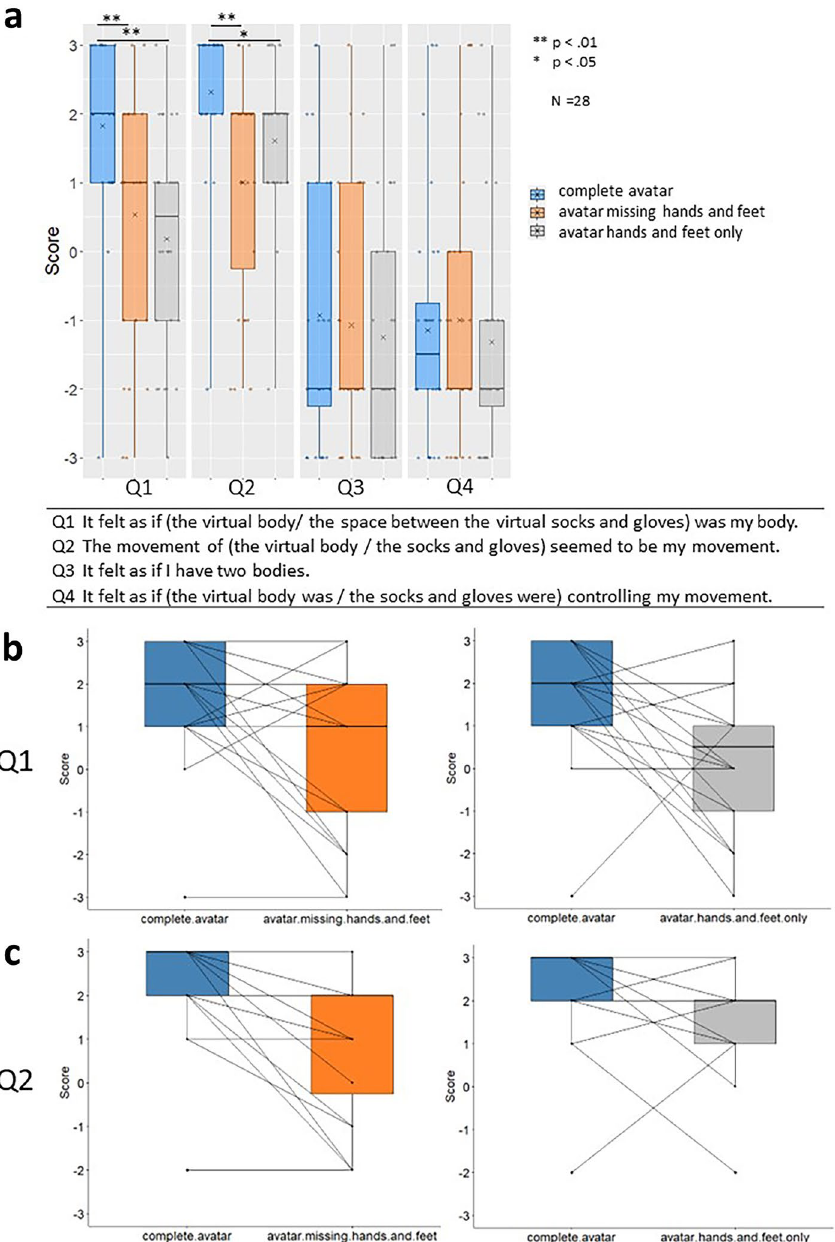
Figure 1. ( a ) All results of the questionnaire. The horizontal thick lines indicate the medians and “x” indicate the mean values. Individual data points are plotted in dots. ( b ) Plots of pairwise comparison lines between individual data points in Q1. ( c ) Plots of pairwise comparison lines between individual data points in